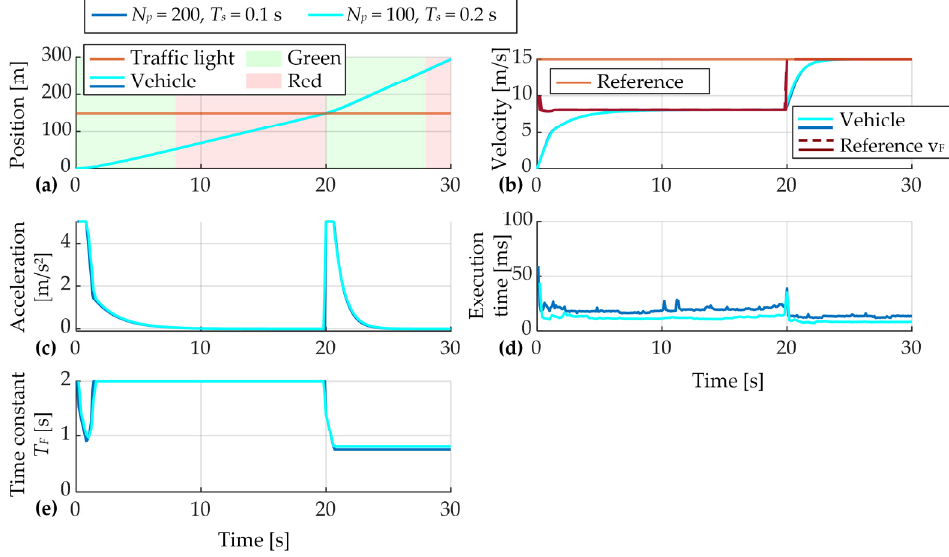
Figure 12. NMPC system responses for different sampling time values. Subfigures show position ( a ), velocity ( b ), acceleration ( c ), execution time ( d ) and time constant control input ( e ).